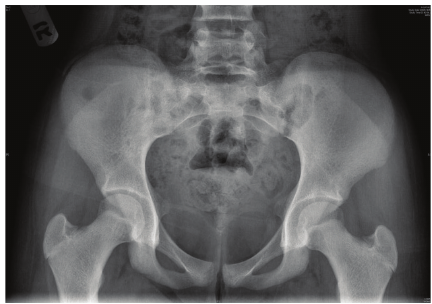
Figure 1: X-ray AP view of the pelvis showing hard to pick changes in the right ilium.